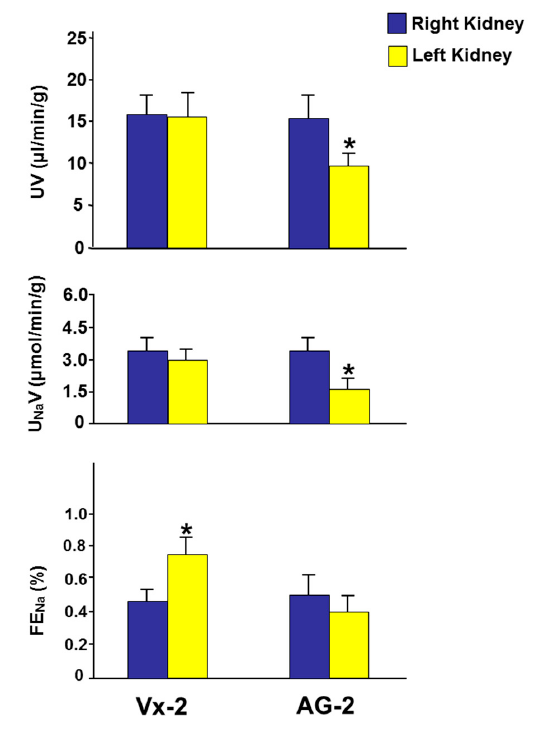
Figure 5. The tubular functional parameters including urine volume (UV), urinary sodium (U Na V), and fractional excretion of sodium (FE Na ) in both kidneys in Vx-2 and AG-1, six days following reversal of left ureteric obstruction. Values represent mean ± SEM. * indicates statistical significance between the right and left kidney within the same